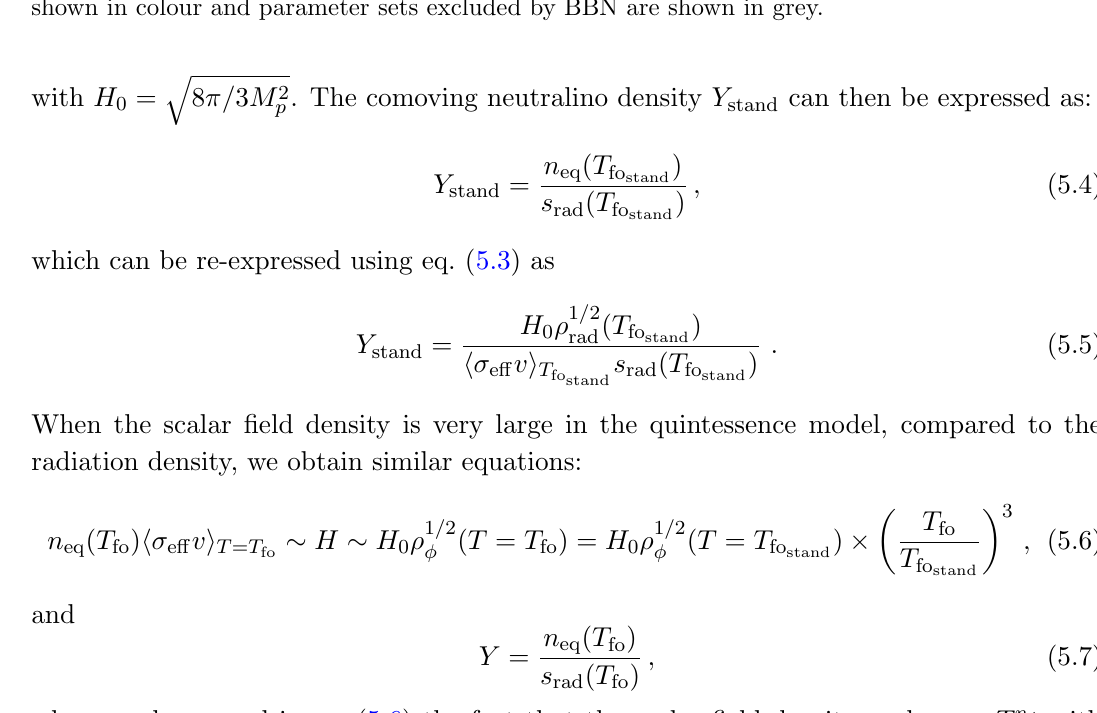
Figure 11. The value of the scalar (cid:12)eld density at freeze-out that is required to increase the relic density up to the observed DM density for our sample of pMSSM19 points. The neutralino mass is shown in colour and parameter sets excluded by BBN are shown in